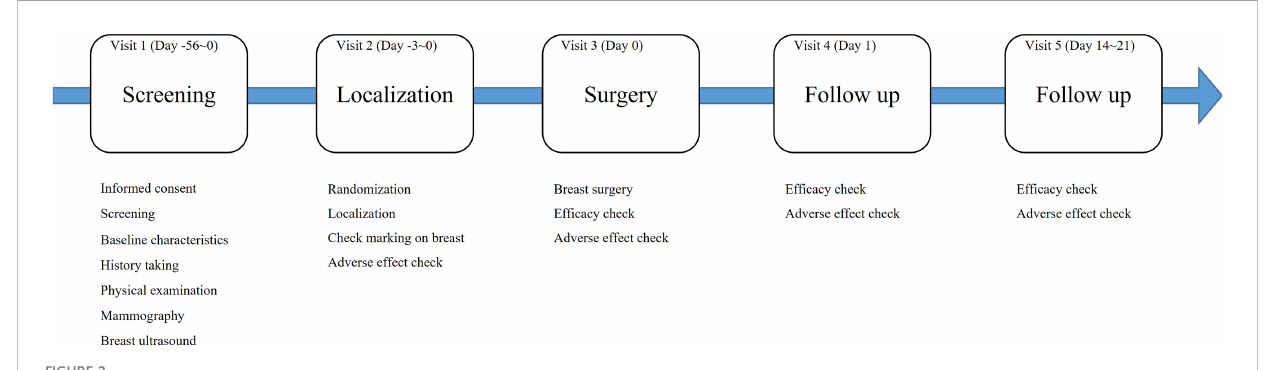
FIGURE 2 Flow chart showing participant enrollment.